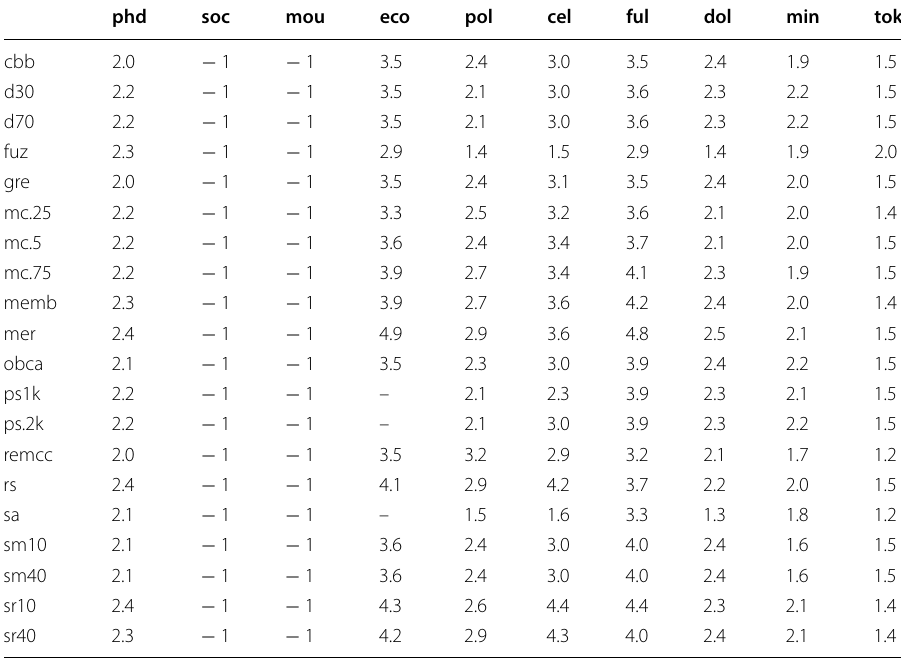
Table 8 Estimated d B values according to the second